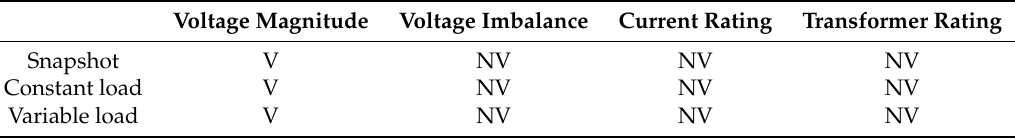
Figure 6. Voltage across all lines in the grid with rated loading in snapshot mode. Table 2. System performance index violations in the examined PV penetration